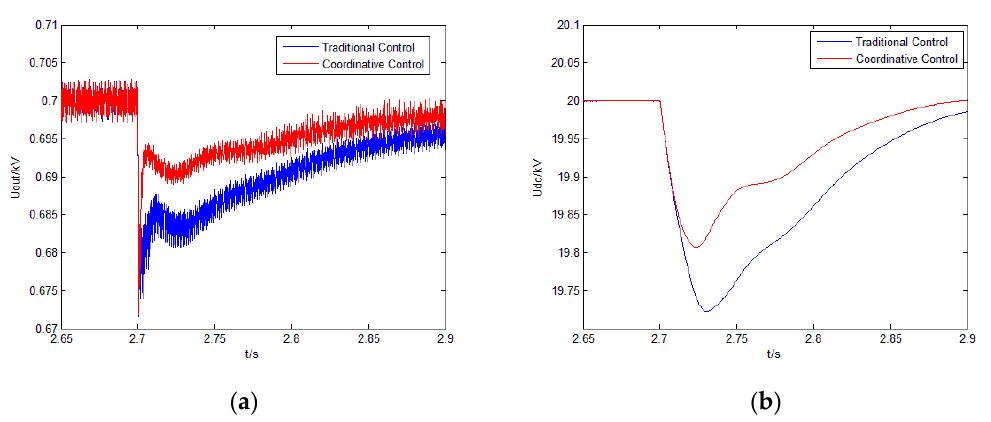
Figure 15. The comparison of voltage response after the DC microgrid is tripped off: ( a ) the LVDC bus voltage response; ( b ) the HVDC bus voltage response.